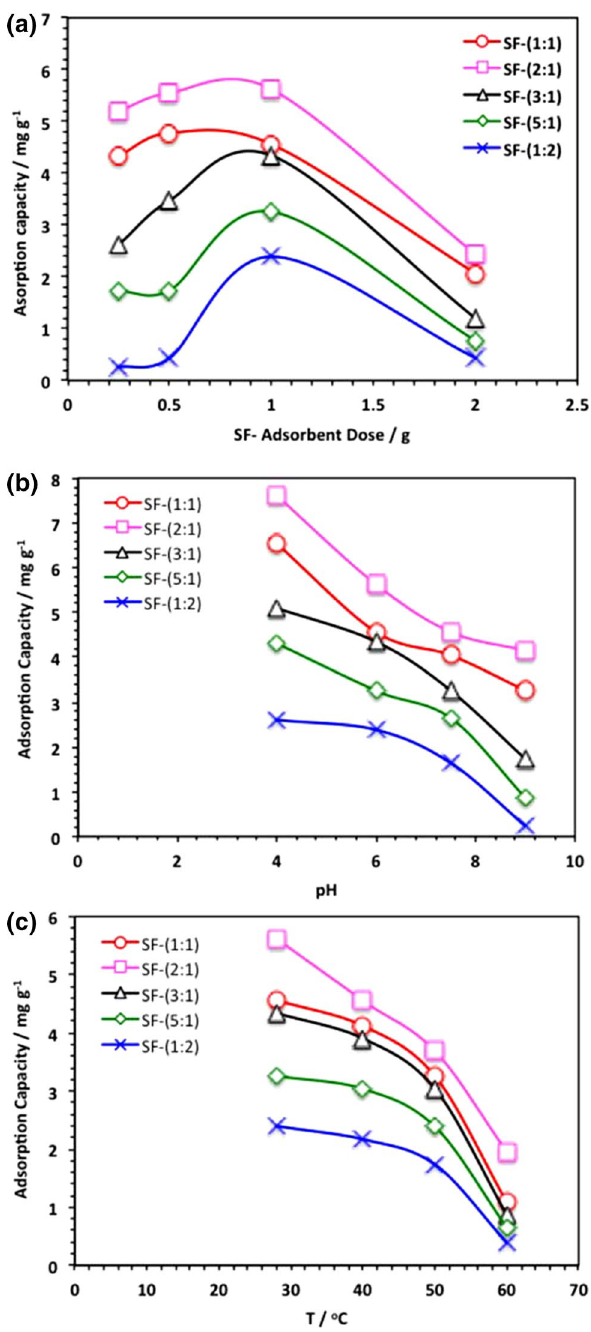
Fig. 8 Effect of various adsorption parameters on the adsorption uptake a SF-material dosing; b pH and c